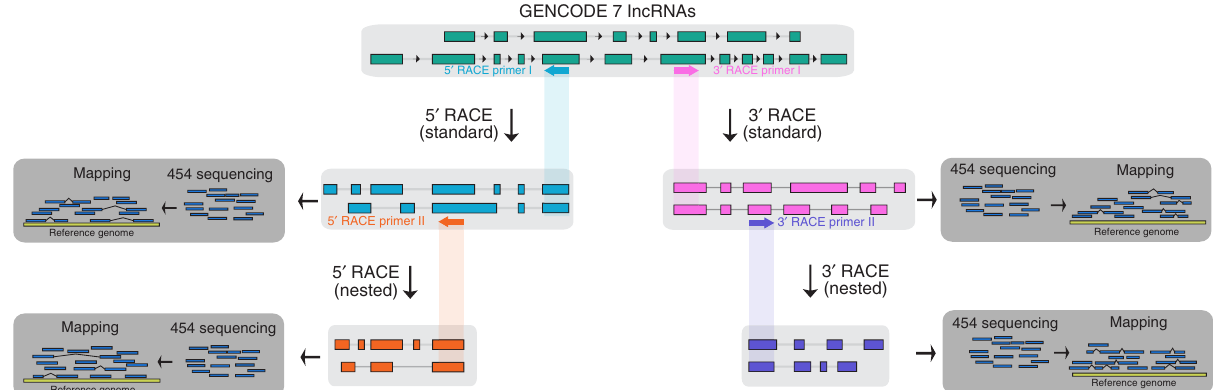
Figure 1 | Schematic overview of RACE-seq. Standard 5 0 and 3 0 RACE primers are designed to target exons of a gene and produce primary RACE products, which undergo a second round of RACE reactions using nested 5 0 or 3 0 RACE primers. Both standard and nested 5 0 and 3 0 RACE products are subjected to long-read sequencing, followed by mapping to the reference genome.